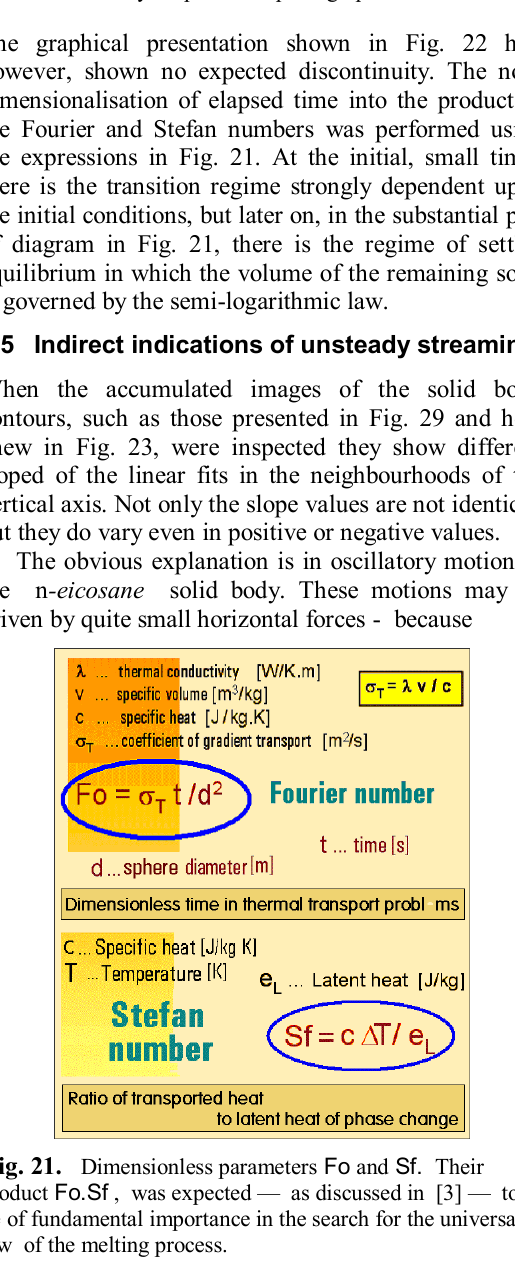
Fig. 20 . Outer shapes of the solid n- eicosane inside the 64.1 mm outer diameter glass flask at the time instants after the separation from the stem {cf. Figs. 6 and 18). The auxiliary horizontal red lines in the right-hand side of the picture were used to identify the surface points for calculating of the melted body shapes in the photographs.